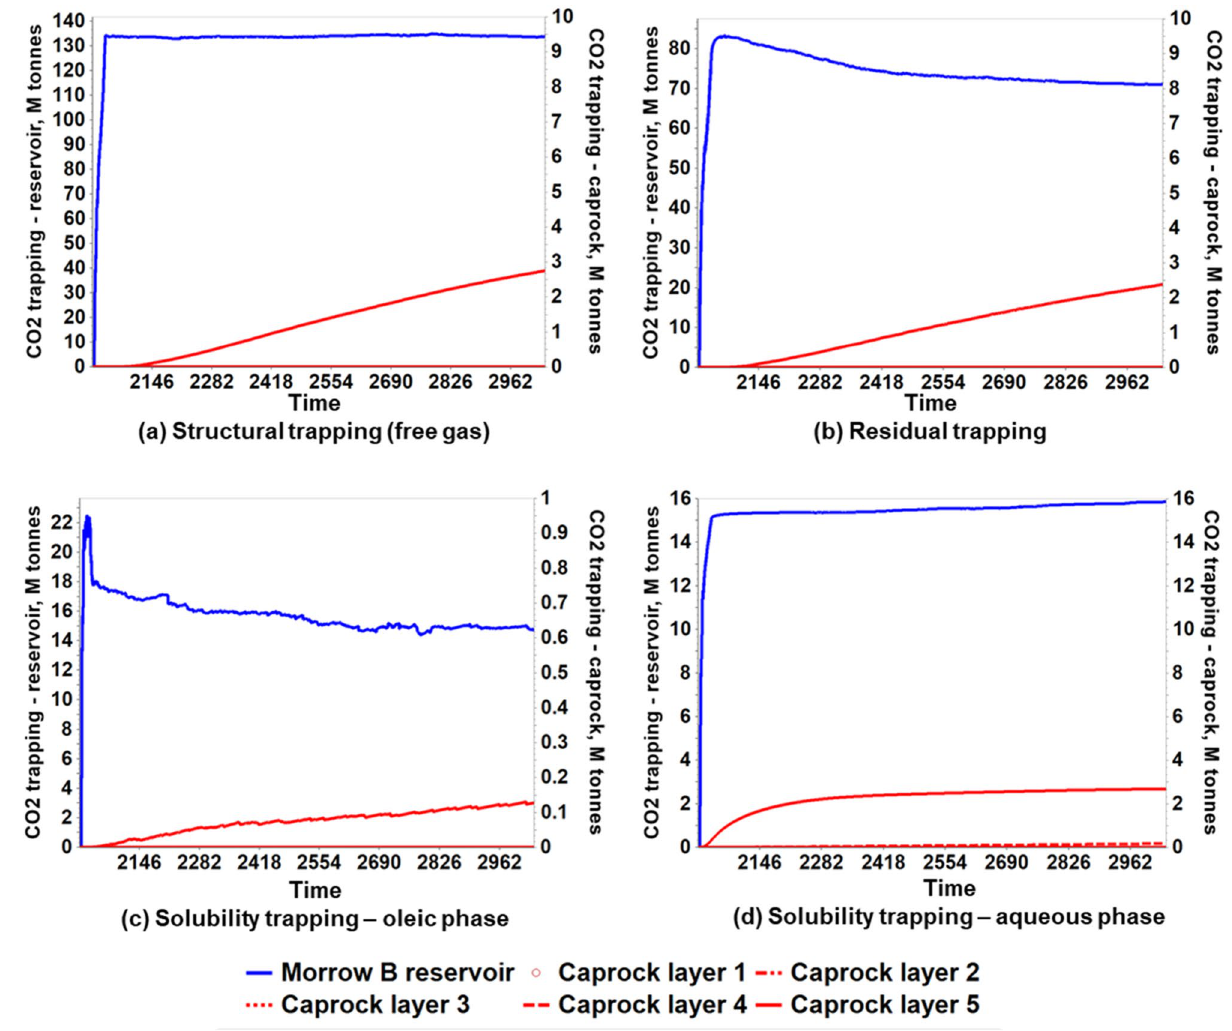
Figure 19. The evolution of CO 2 storage distribution in reservoir and